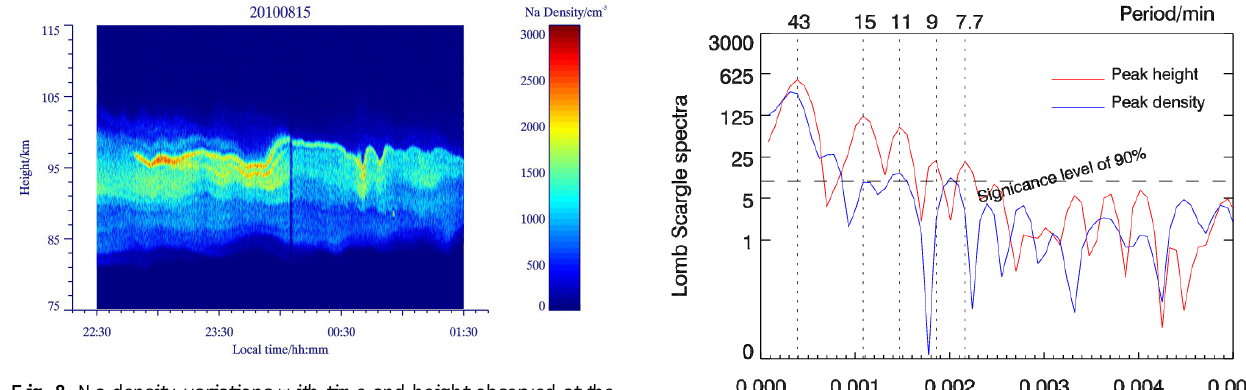
Fig. 8. Na density variations with time and height observed at the time resolution of 1.5s on the night of 15 August 2010 to show the concurrent multiple thin layers with similar movement.